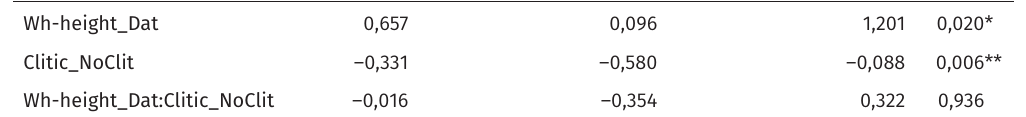
Table 5: Study 2 – Generalized linear mixed model fitted by using Markov chain Monte Carlo techniques (Hadfield 2010) with Gaussian family.